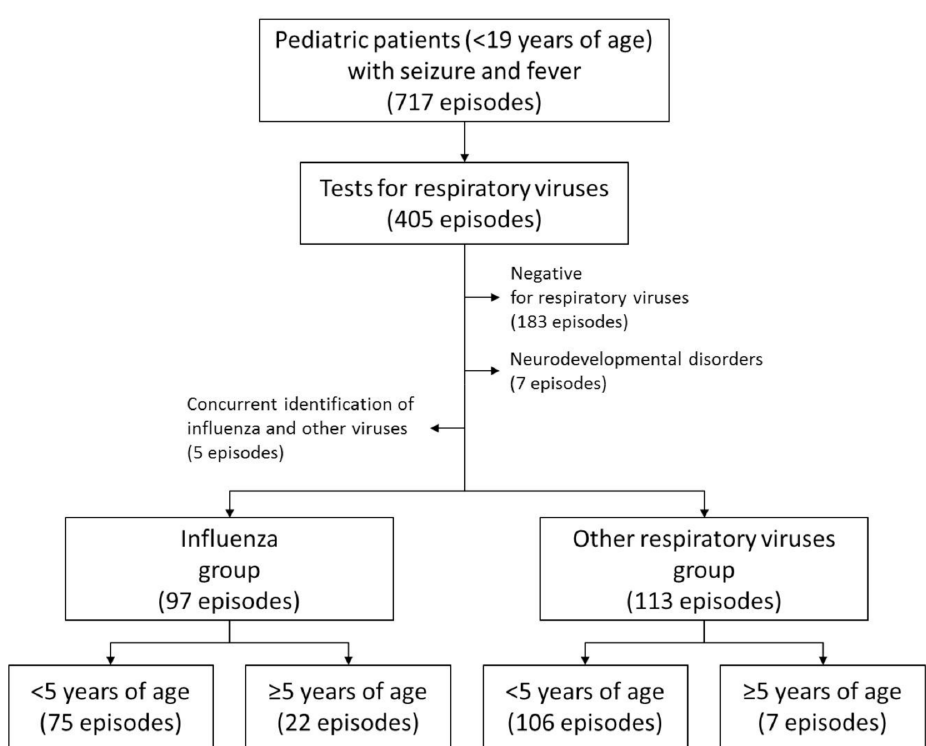
Figure 1. Flow chart for study